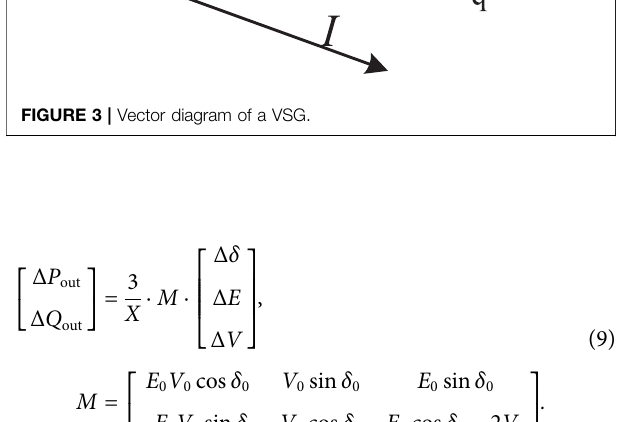
Figure 1 . illustrates the model of a single VSG connected to the in fi nite grid, with the DC side of the VSG ignored. Figure 1 shows two main control loops: active power control loop (APCL) and reactive power control loop (RPCL). The P - ω droop, Q - V droop, and swing equation are contented. Their detailed block diagrams are shown in Figure 2 . In Figure 2 , k p and k q are the droop coef fi cients of each loop